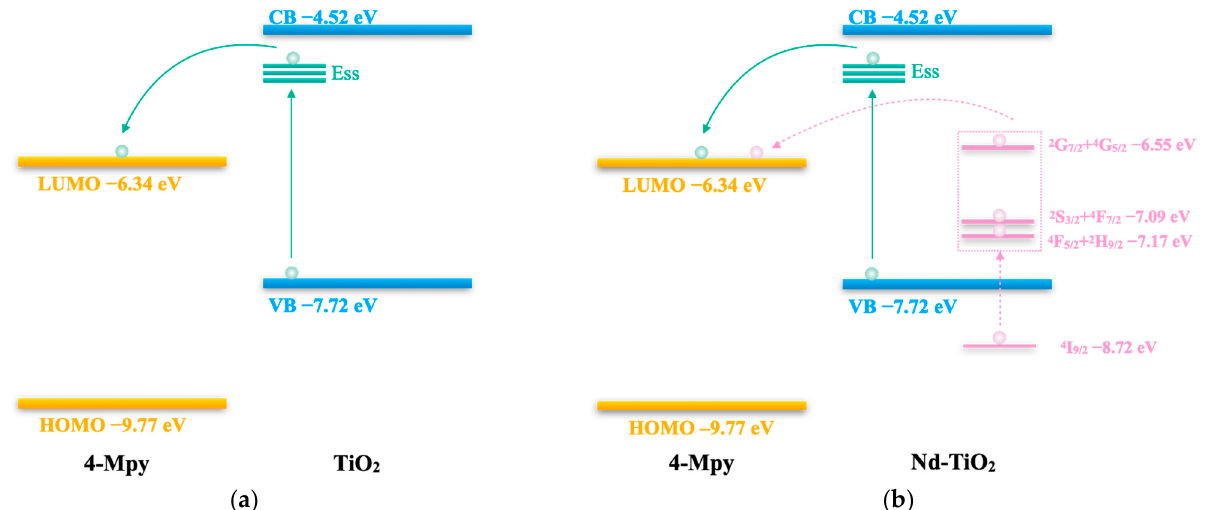
Figure 6. Schematic diagram of the charge-transfer (CT) mechanism for SERS between ( a ) 4-Mpy and TiO 2 and ( b ) 4-Mpy and Nd-TiO 2 .